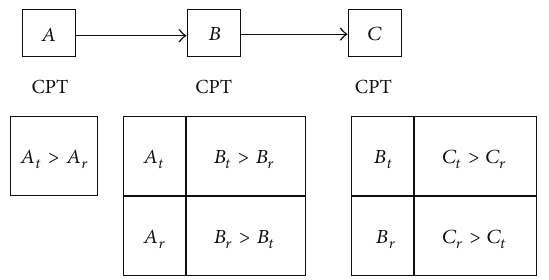
Figure 1: The users’ preference expression map.